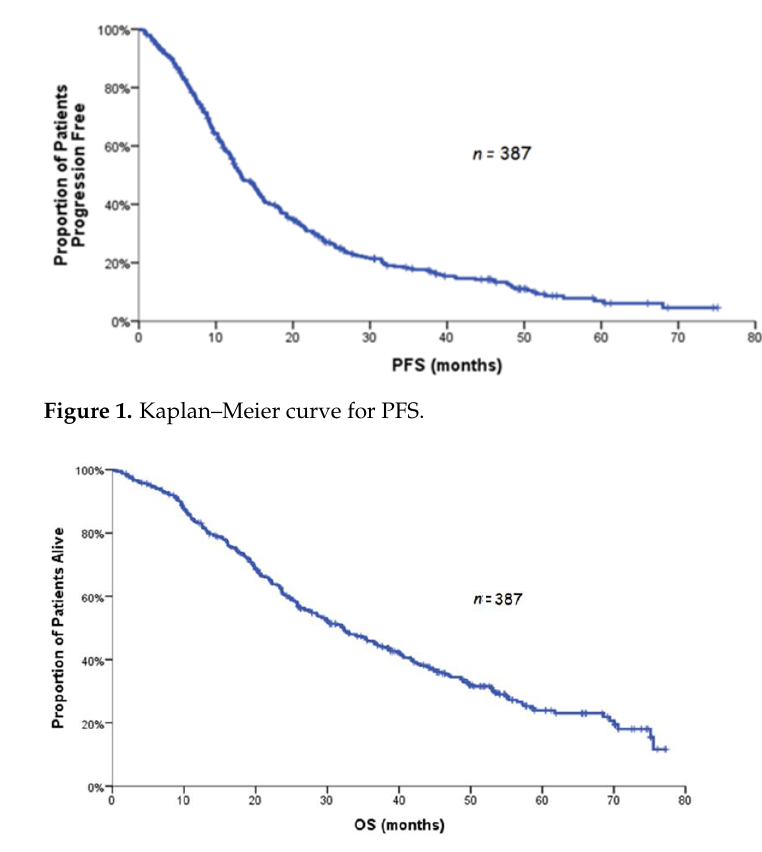
Figure 2. Kaplan–Meier curve for Figure 2. Kaplan – Meier curve for OS. Figure 2. Kaplan – Meier curve for OS.